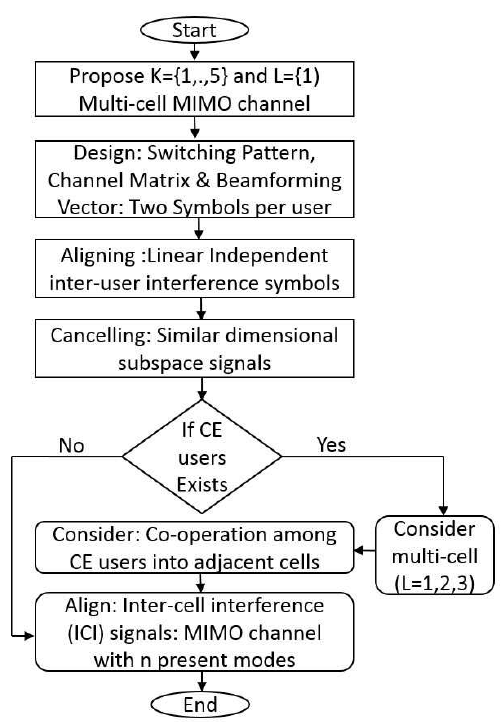
Figure 2. Step-by-step procedure of the proposed optimisation framework.